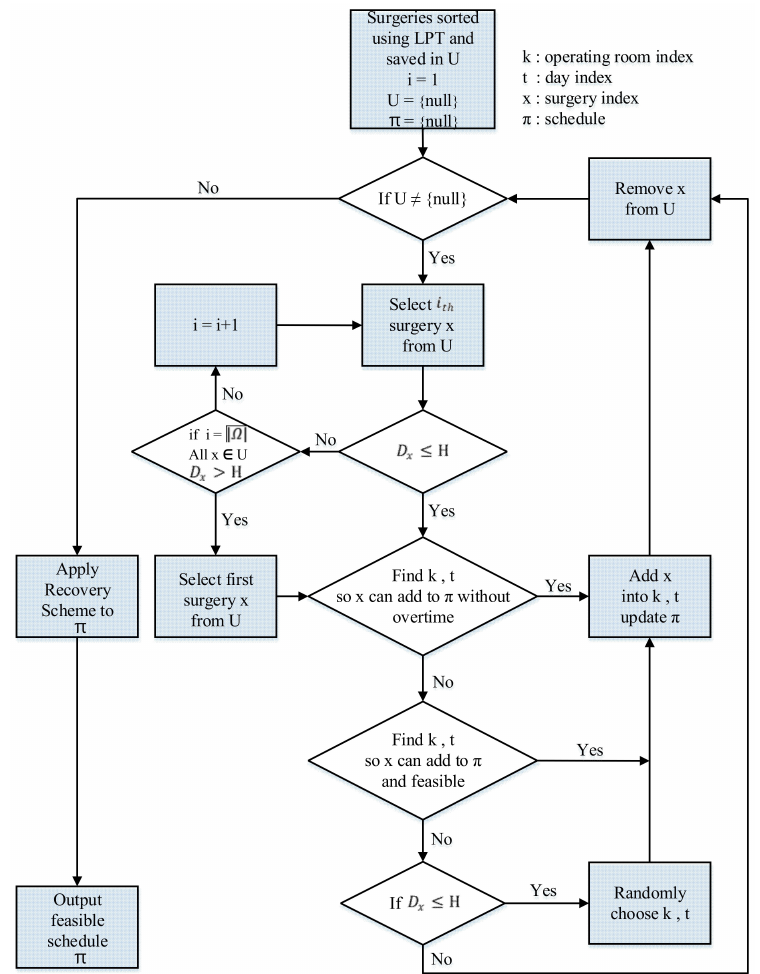
Figure 2. The flow chart of modified longest processing time (MLPT)